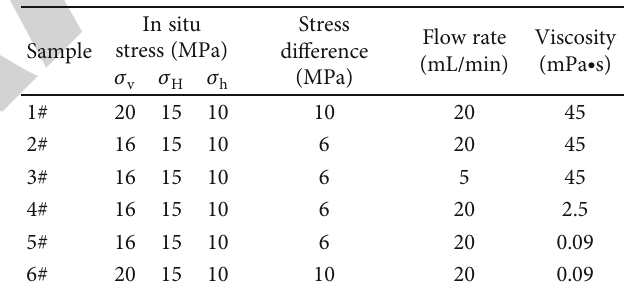
Table 1: Experimental